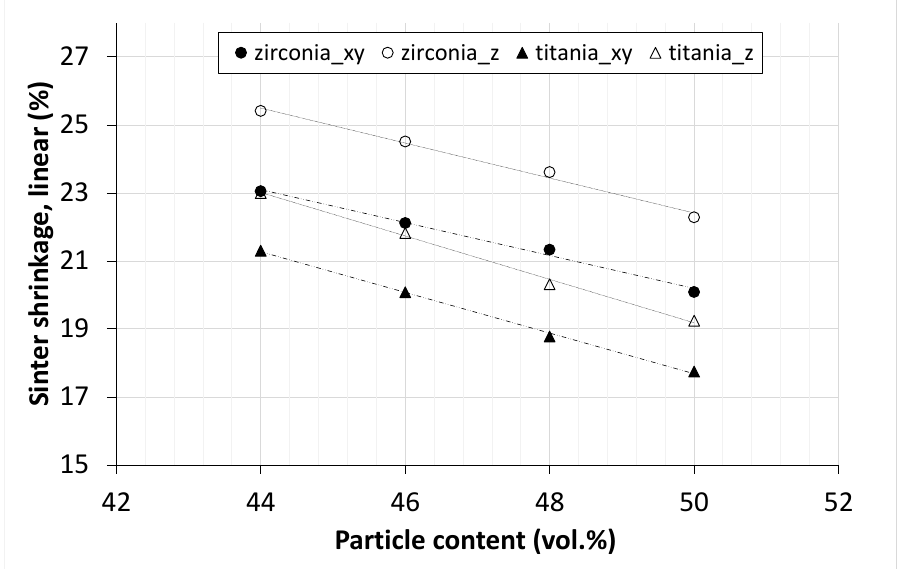
Figure 10. Sintering shrinkage in x ‐ , y ‐ and z ‐ direction of zirconia (circles) and titania (triangles) depending on the solid content .